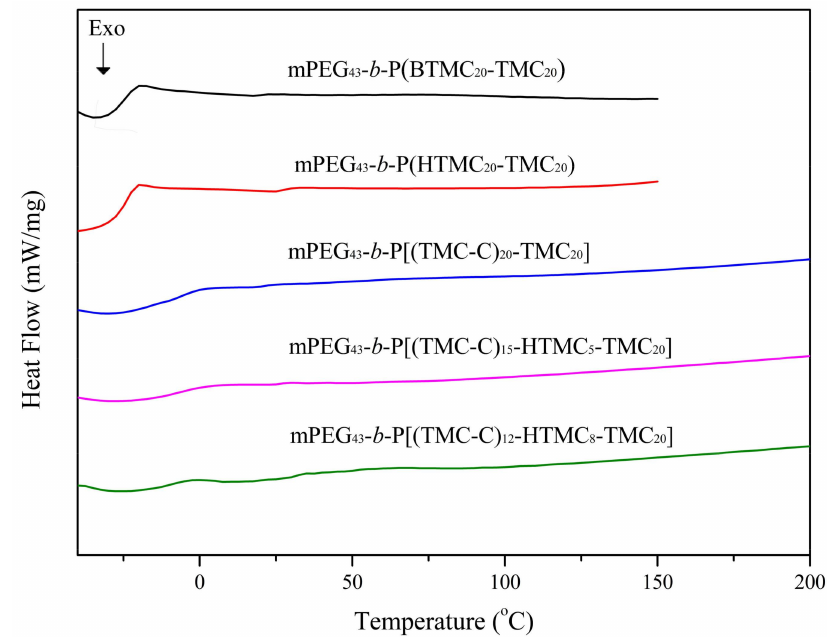
Figure 2. DSC curves of the